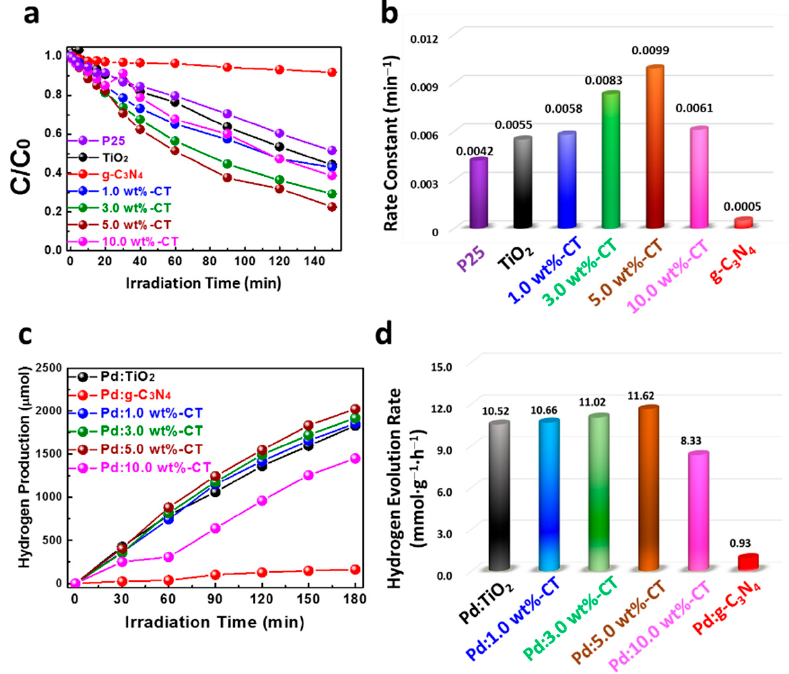
Figure 6. ( a ) Photodegradation of methyl orange and ( b ) the comparison chart of degradation rate; ( c ) photocatalytic hydrogen production and ( d ) the comparison chart of production rate.